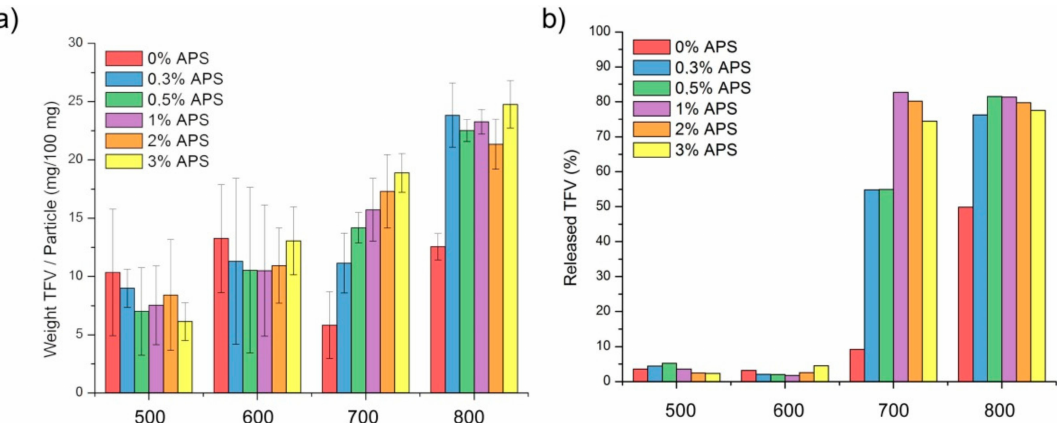
Figure 8. ( a ) mg of TFV adsorbed per 100 mg of particles ( b ) Percentage of TFV released after 180 min in SVF. In the x-axis it is shown the temperature at which the particles were